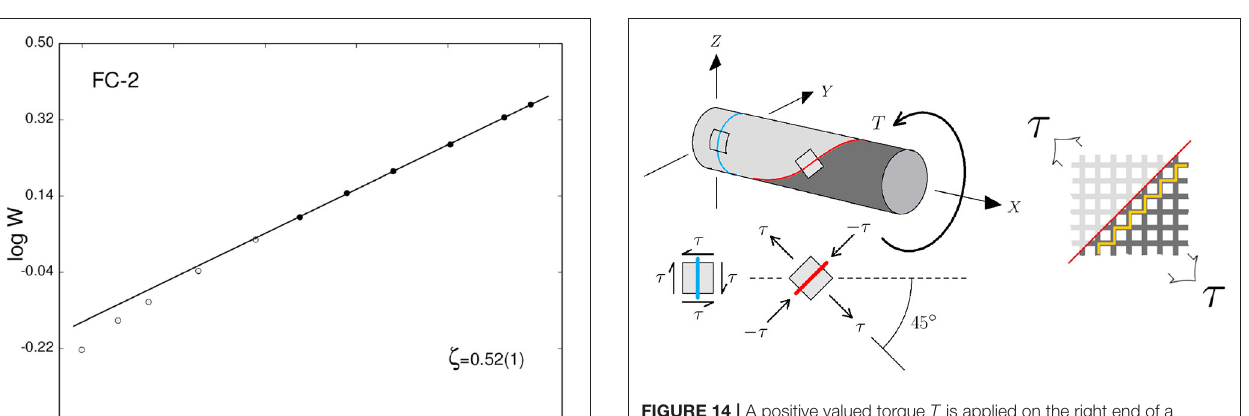
FIGURE 14 | A positive valued torque T is applied on the right end of a cylindrical shaft, with the left end being held fixed. Shown in blue is an intersecting plane on which the shear stresses are at their highest. The associated material element is one of pure shear, with the largest values obtained vertically or horizontally. Shown in red is an intersecting helical surface perpendicular to which tensile forces are highest. The associated material element indicates the direction and value of the maximum tensile and compressive normal stresses. This element is contained within the lattice discretization on the right, with a numerical realization of the helical surface depicted in